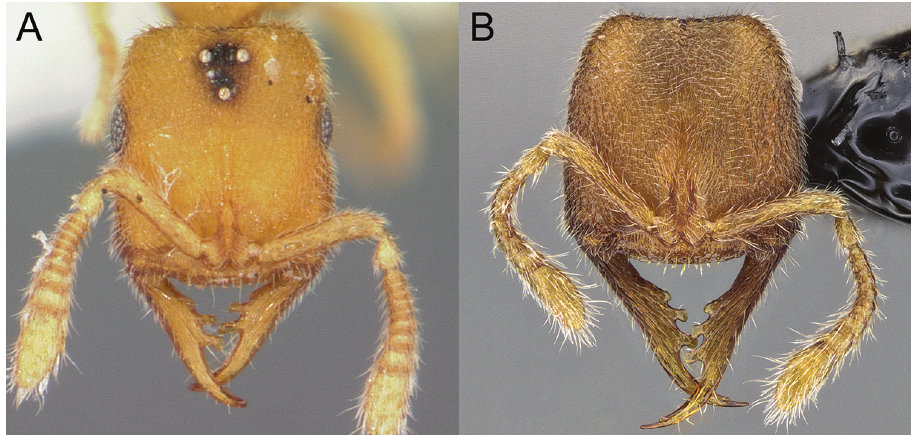
Figure 8. Stigmatomma mulanae and S. luyiae sp. n. A Holotype of S. mulanae (CASENT0104980); queen; full-face view. Image by April Nobile; available at AntWeb.org B Holotype of S. luyiae (CASENT0922349); worker; full-face view. Image by FAE; available at